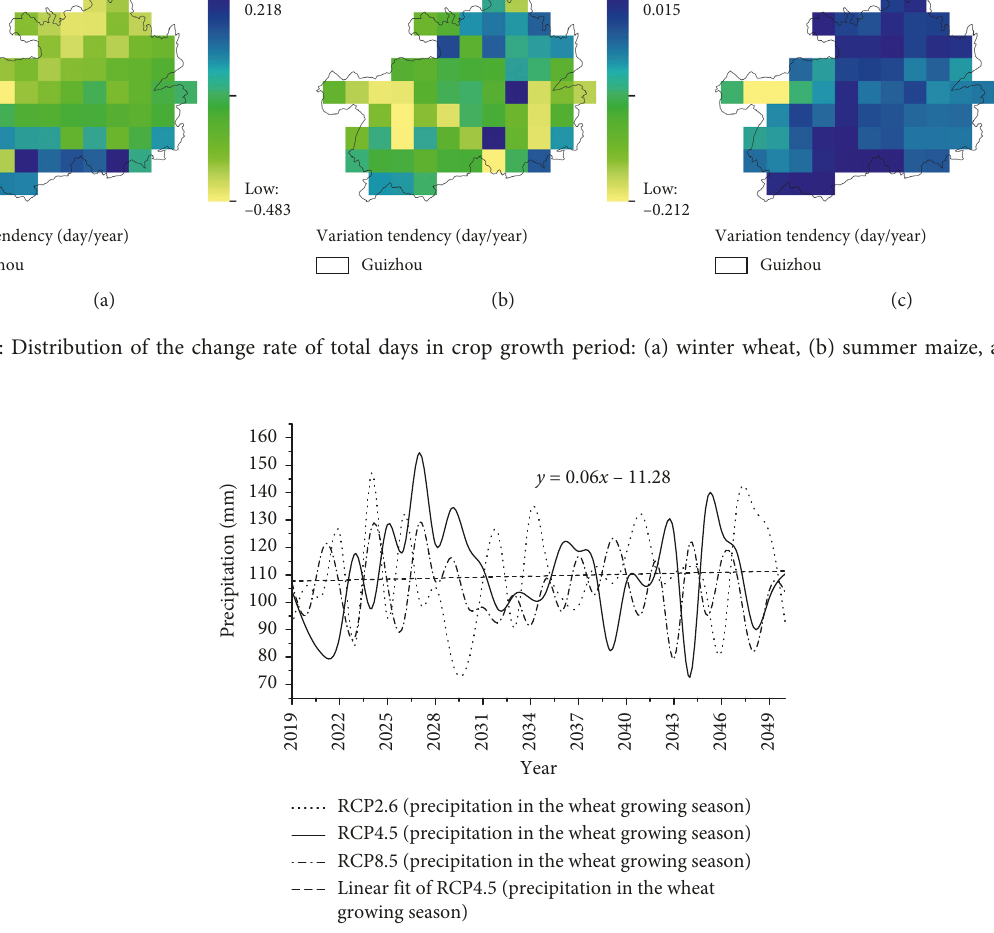
Figure 15: Precipitation trends during the wheat growing season (December to March) from 2019 to 2050.